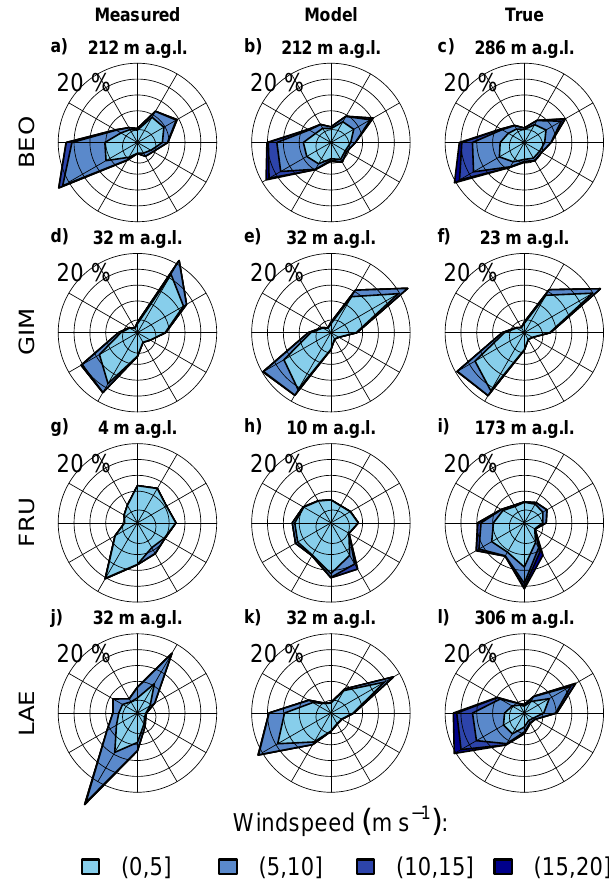
Figure 4. Wind roses at the four measurement sites during the study period (1 March 2013–28 February 2014) for observed (first col- umn) and simulated horizontal wind at two different model heights: at the height of the measurement a.m.g.l. (Model, second column), and at the true height of the measurement a.s.l. (True, third column). The wind roses display the wind speed probability distribution split into incident 30 ◦ wind direction bins. Wind from the north is up- ward and circular lines demarcate graduating 5th percentiles. Labels above each panel show the height above ground for the measure- ments (first column) and height above the COSMO-2 model ground for the simulated data (second and third